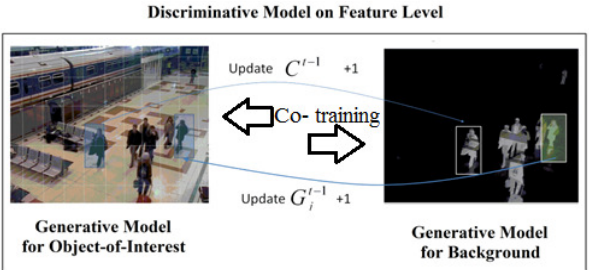
Figure 3. Classifier grids co-training: classifier